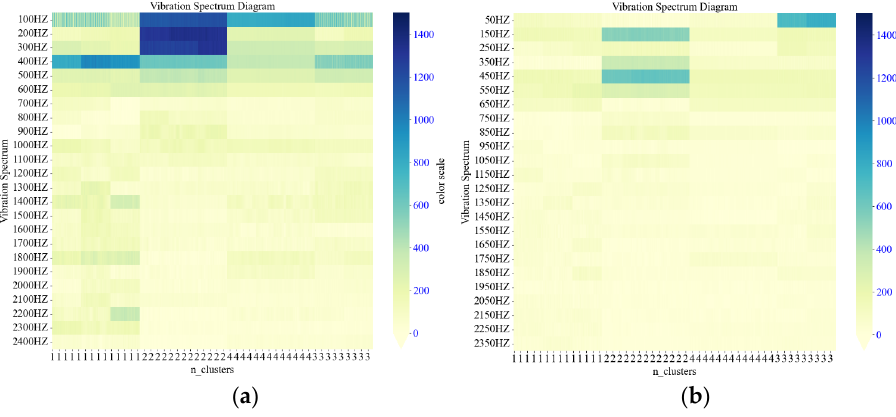
Figure 11. Vibration spectrum clustering heat map at fault: ( a ) Even times; ( b ) Odd times.